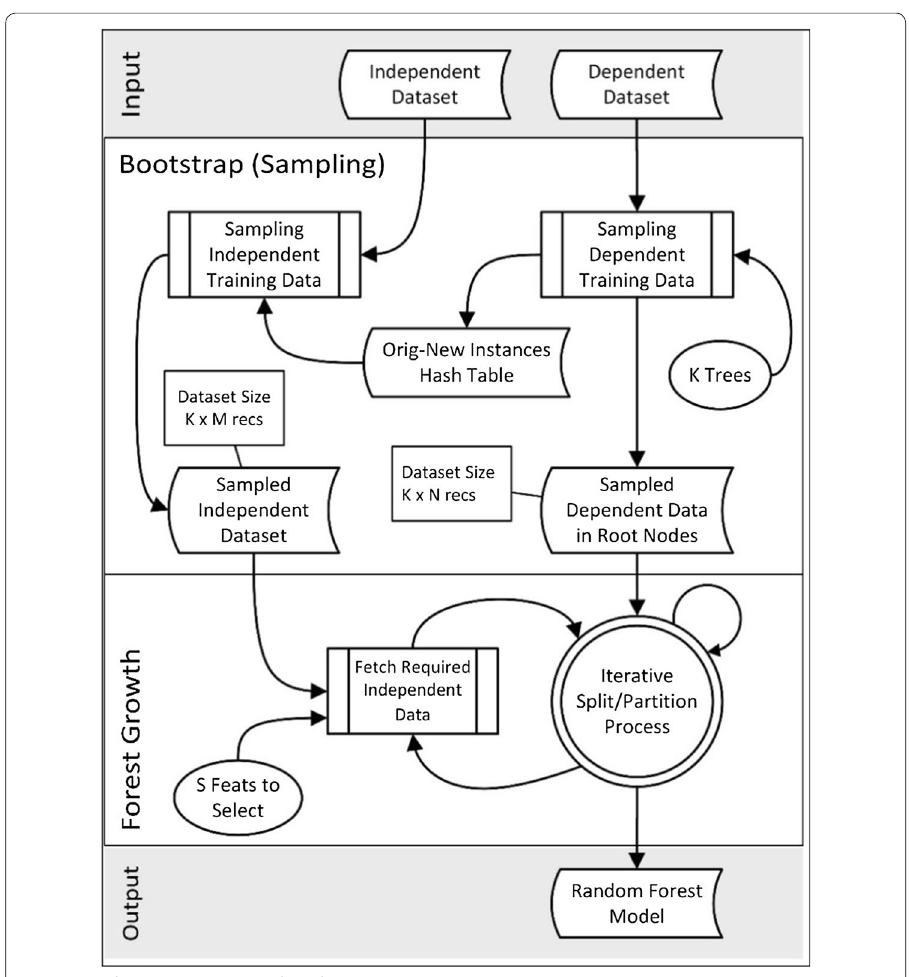
Fig. 7 Random Forest optimized